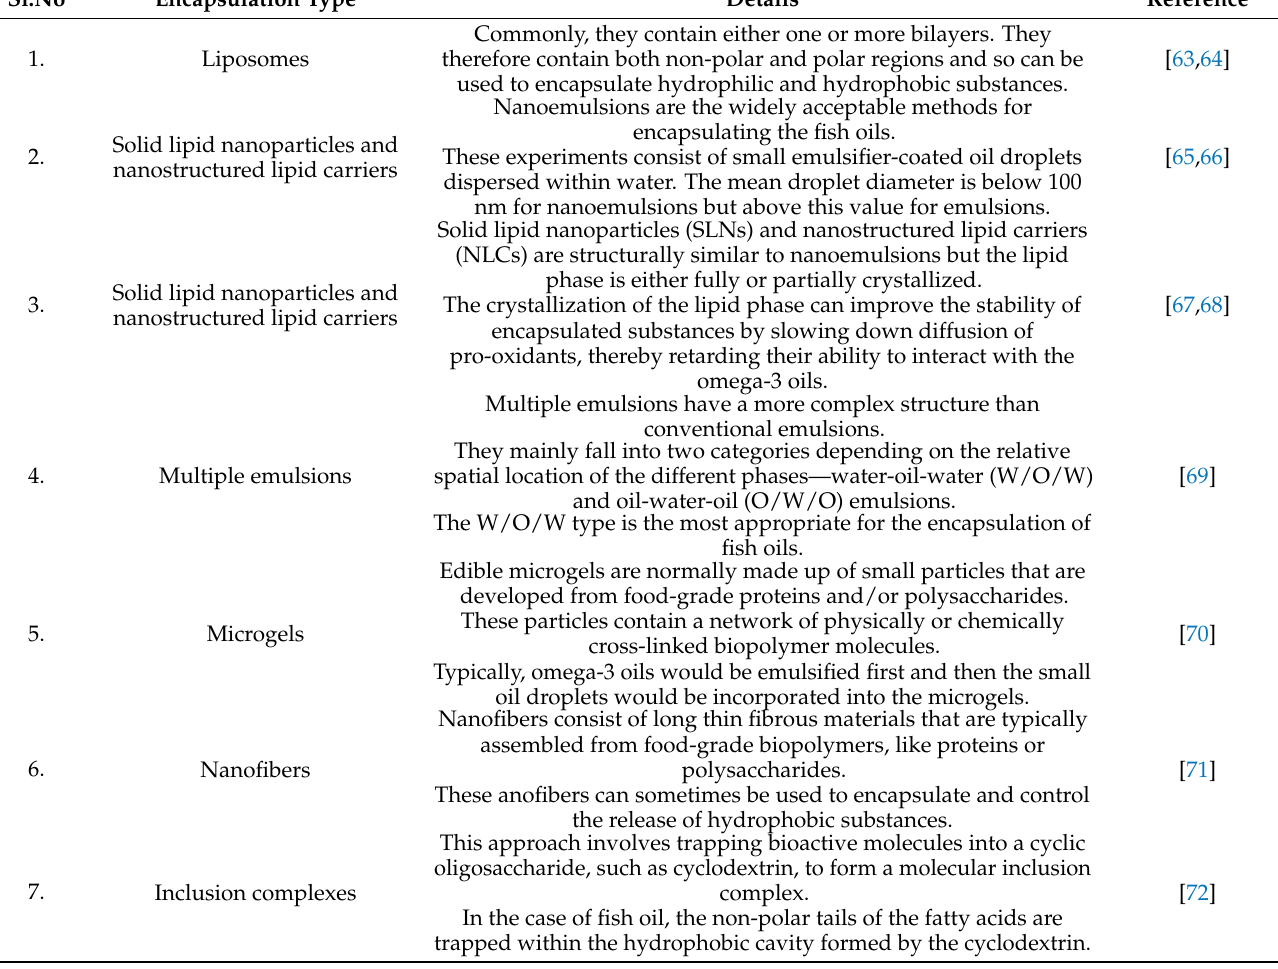
Table 1. Different kinds of delivery systems that have been used to encapsulate omega-3 fish oils. Sl.No